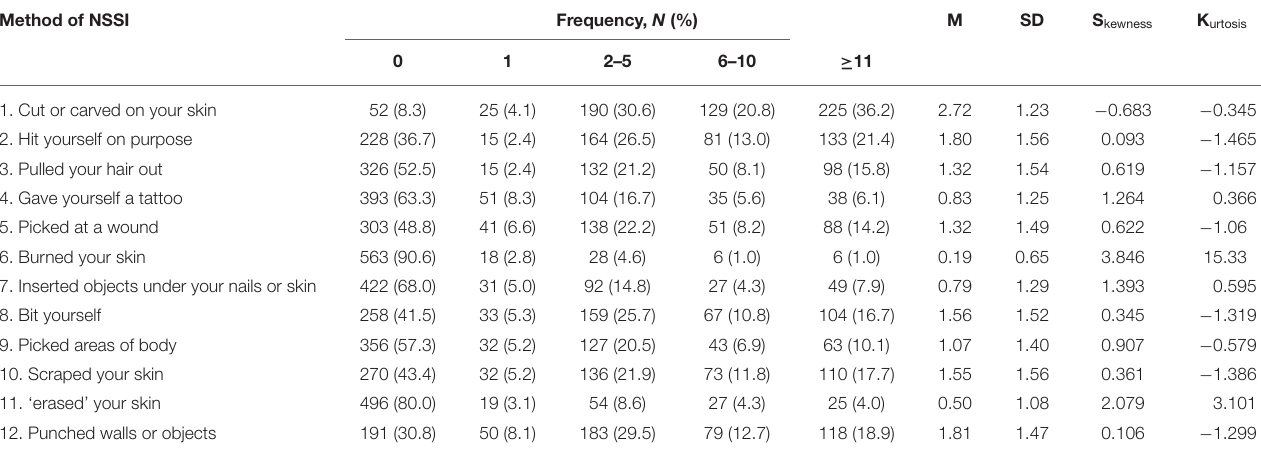
TABLE 1 | Distribution of responses for FASM method checklist ( N = 621).